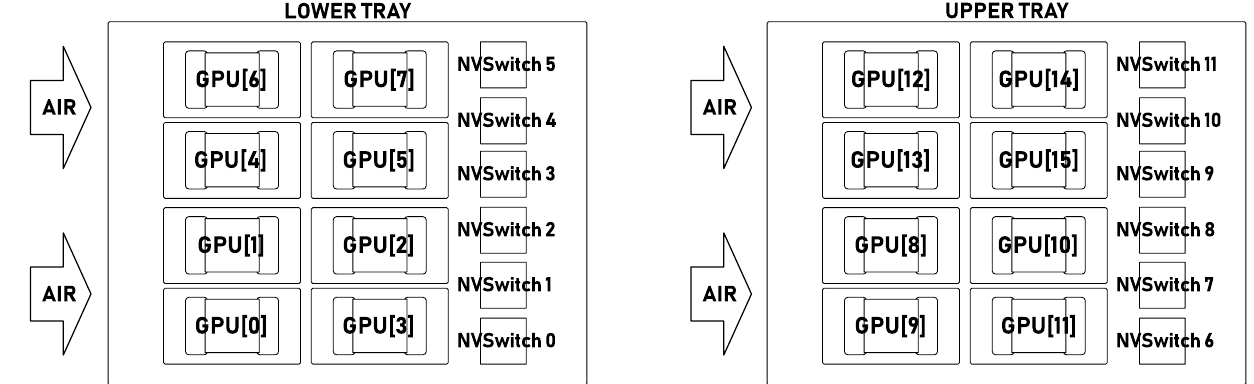
Figure 1. Physical GPU layout of the DGX-2 server